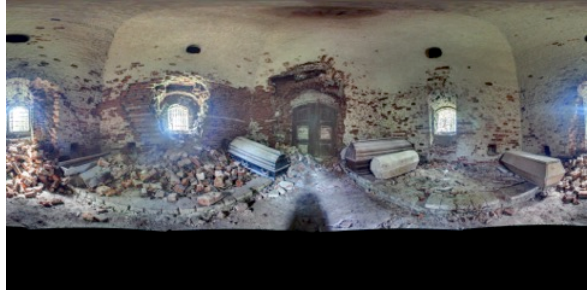
Figure 13. Blow up of a 360° panorama showing the interior of the tomb (photo by J.